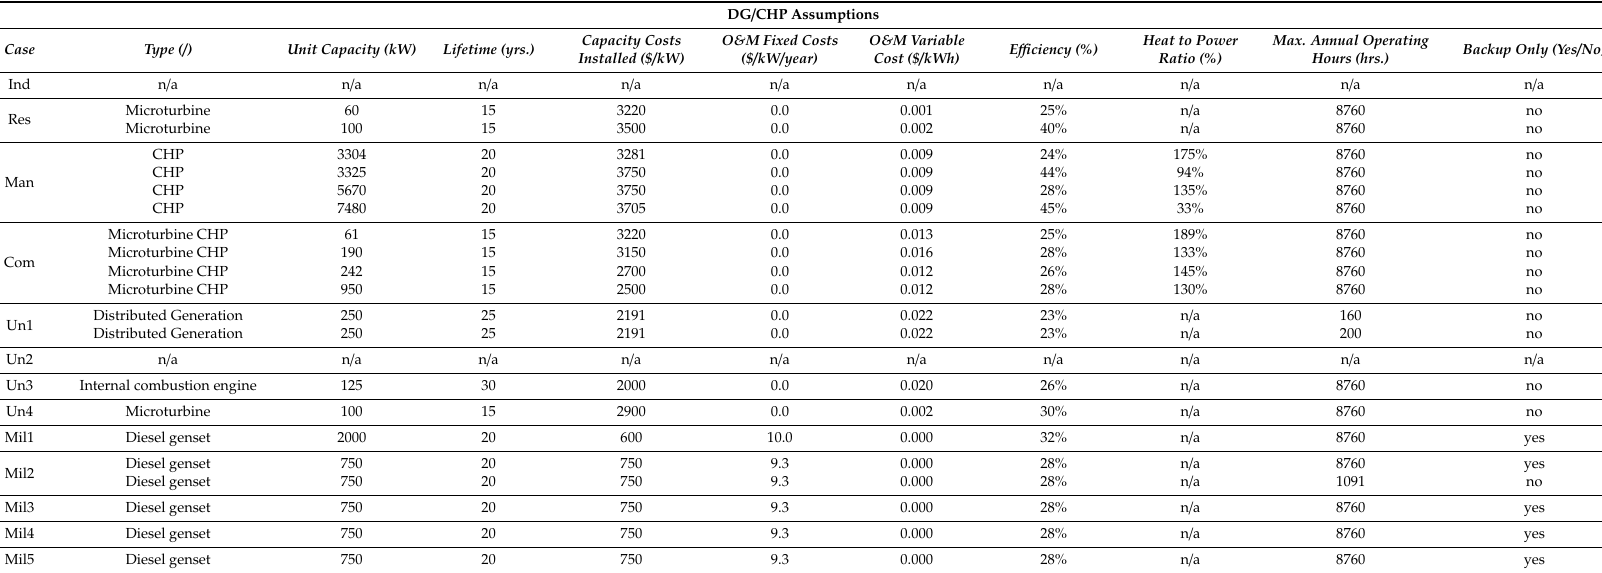
Table A4. Summary Fuel fired Distributed Generation (DG) and Combined Heat and Power (CHP)